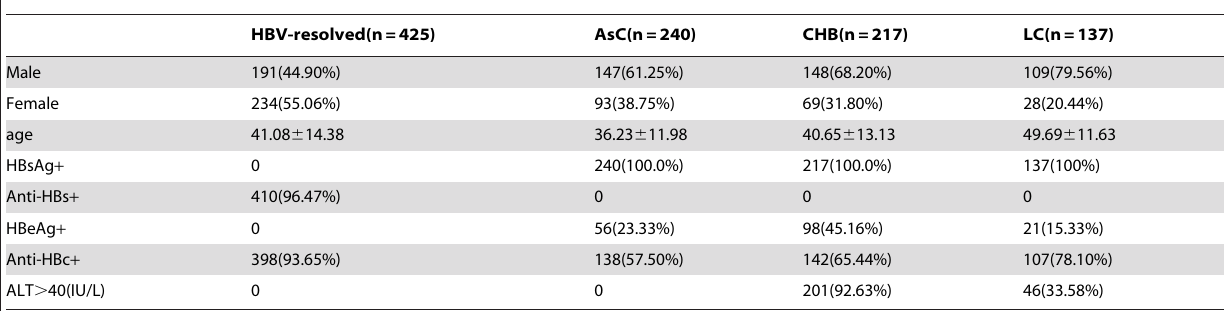
Table 1. Baseline characteristics of study subjects.